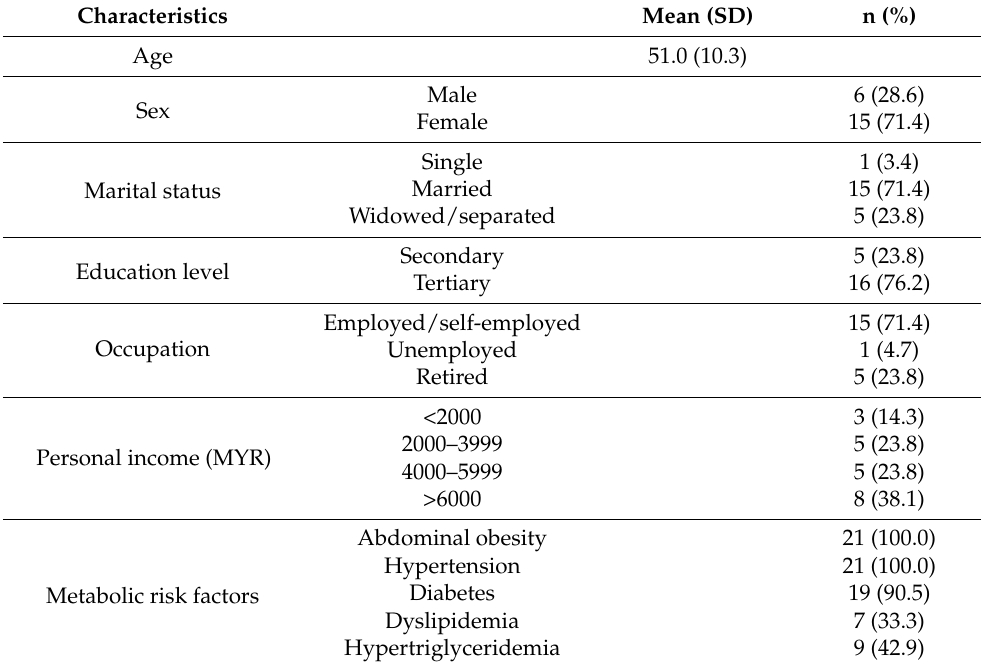
Table 1. Characteristics of the study respondents (N = 21).